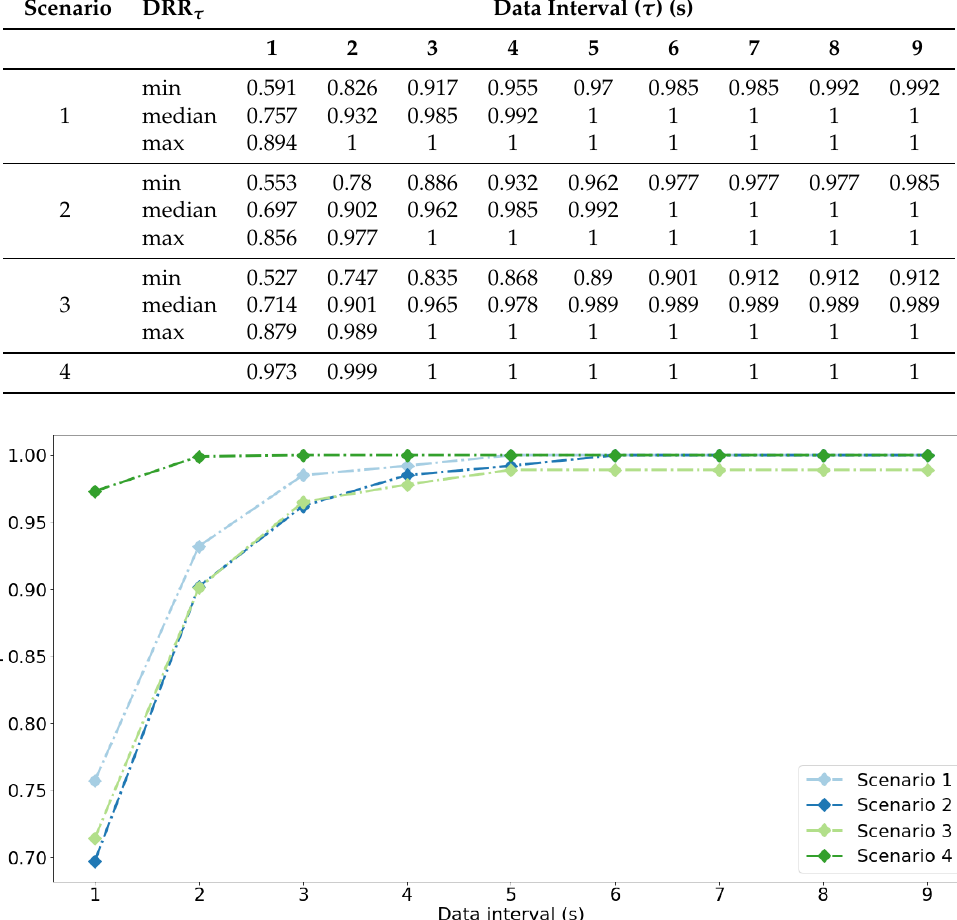
Figure 5. Median of DRR τ estimated from real-life experiments for the scanner S1, various scenarios and data intervals τ <